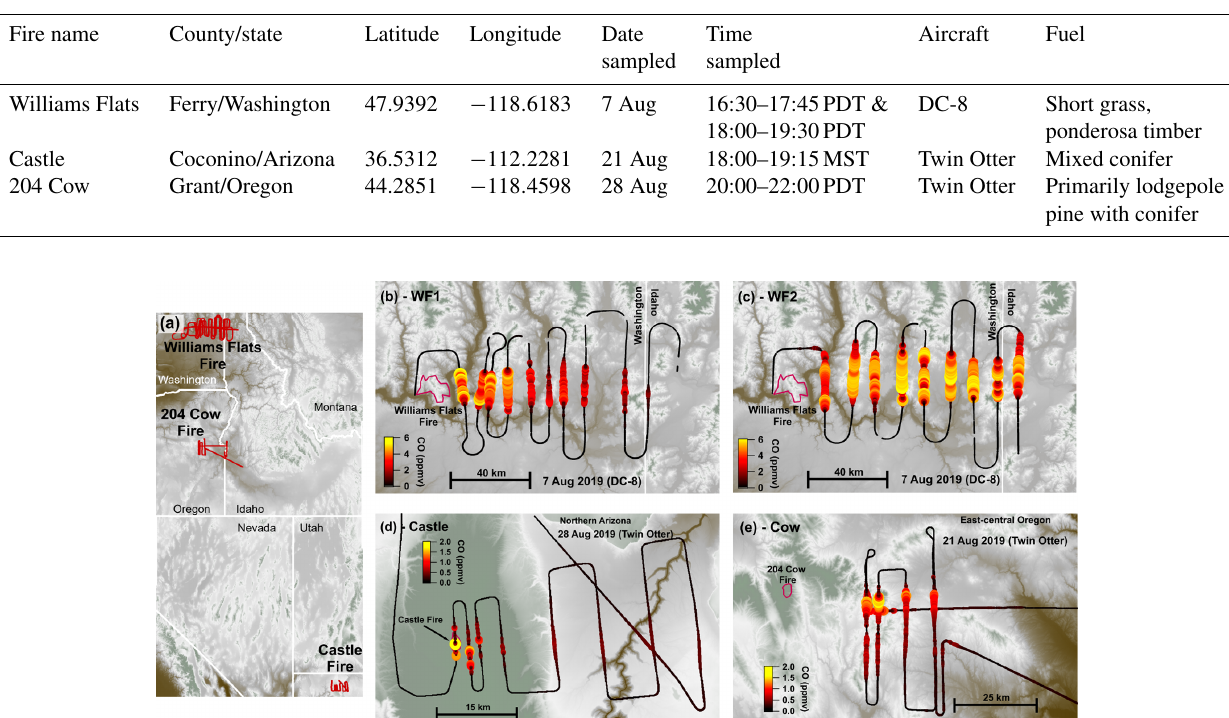
Table 1. Details of fires studied.